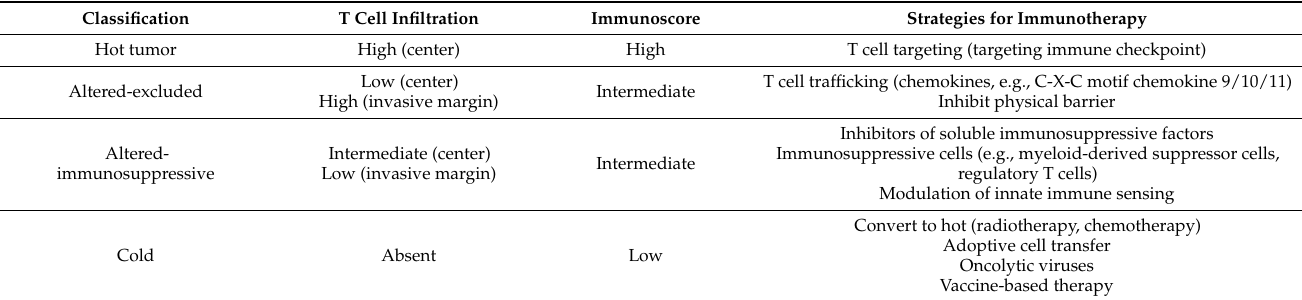
Table 1. Tumor classification based on immune